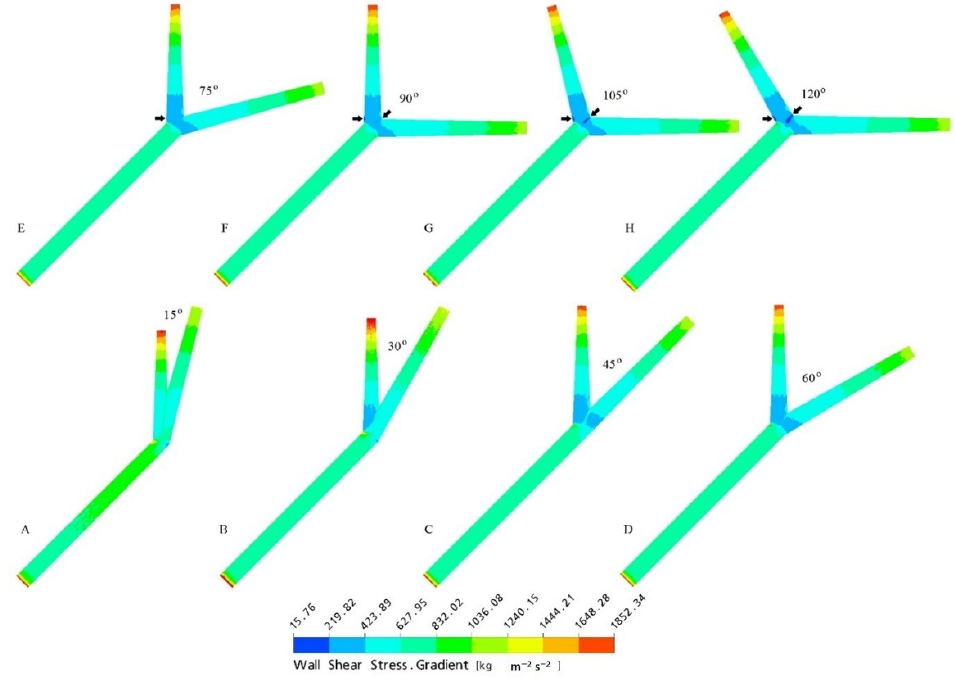
Figure 8. Wall shear stress gradient observed with variable angles of the simulated left coronary artery models generated at peak systolic phase of 0.4 s. ( A – H ) simulated coronary artery models with different LAD-LCx angles ranging from narrow to wide angulation. Arrows refer to the wall shear stress gradient distributions and a big region of the low magnitude present at 120° angulation model. Reprinted with permission from Chaichana et al. [11] 2011, Elsevier.